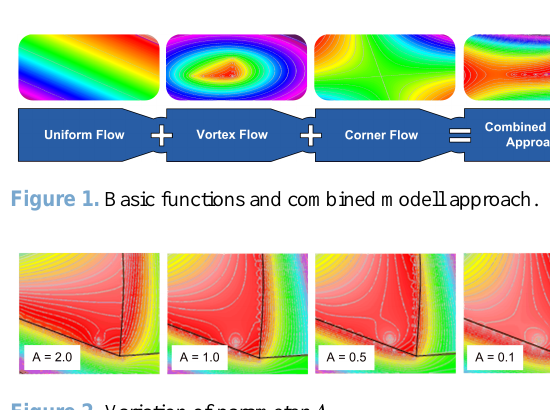
Figure 2. Variation of parameter A .